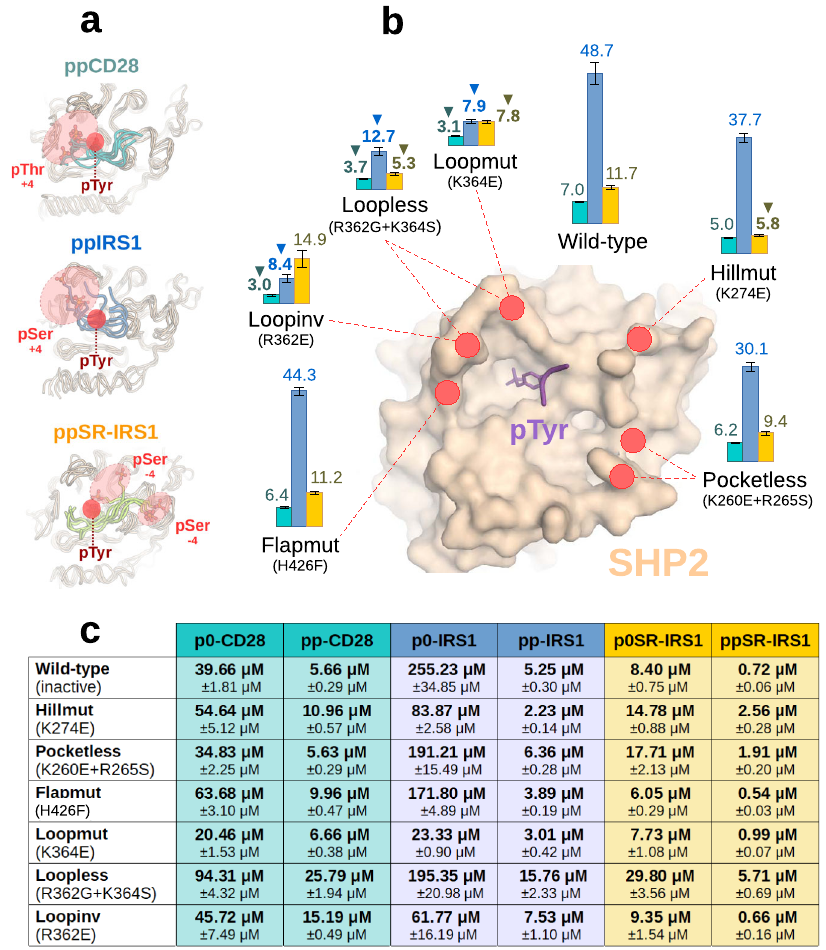
Fig. 6 | Experimental validation of structural models. a Aligned end states for three SHP2-substrate complexes after 10ns MD simulations (a total of 5 for each complex), indicating the broader regions where the pSer or pThr amino acids are located. b TheeffectofSHP2surfacemutationsonphosphoserinerecognition.The surface fi gure indicates the positive charges altered in each mutant, while the bar plots and numbers indicate the relative binding strength of the two peptides (Kd( pSer) /Kd( pTyr + pSer ) or pThrin case ofCD28).The bluebars refer to the IRS Y632-S636 peptides, the green bars show the behaviour of the CD28 Y191-S195 peptides, while the IRS1 S892-Y896 peptides are indicated by the yellow bars. The underlying experiments had n =3 technical repeats, yielding Kd values with error estimates after nonlinear curve fi tting (Supplementary note 1). Mean and ±SD estimates for the Kd ratio distributions shown on the bar plots were calculated